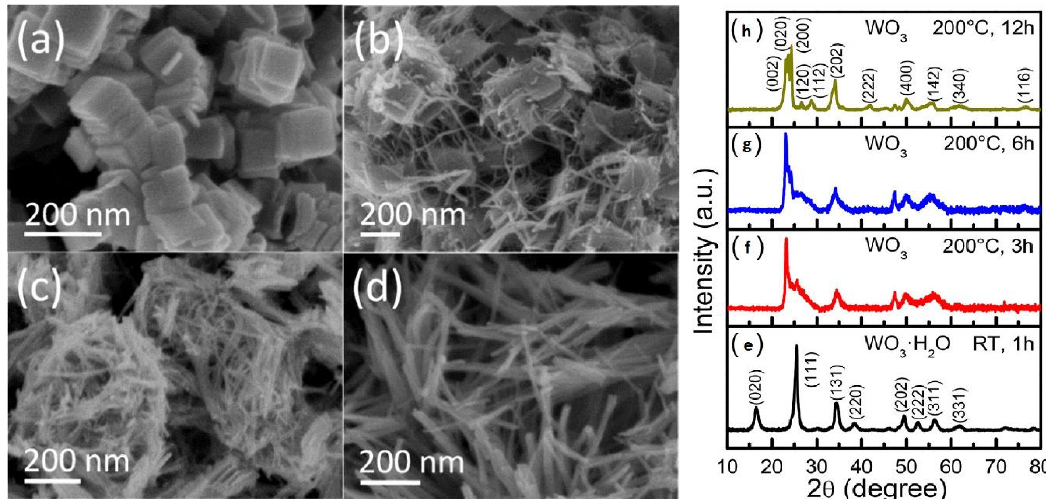
Figure 7 Figure 7. SEM images. ( a ) Stacked WO · H 3 2 O square nanoplates synthesized at room